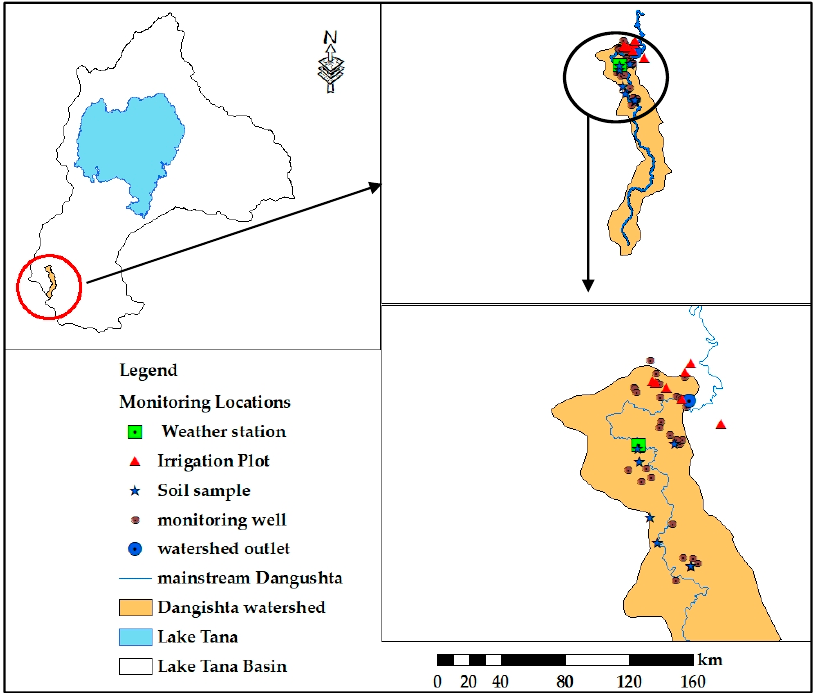
Figure 1. Map of the study area (Dangishta watershed in Ethiopia) showing different monitoring systems.